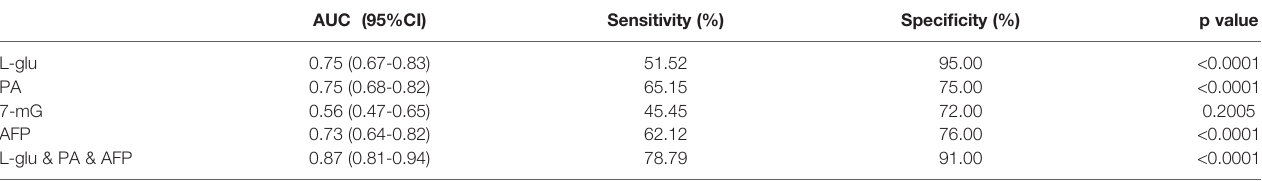
TABLE 2 | The diagnostic performance of serum metabolites, AFP or their combination for HCC detection in MetS population.